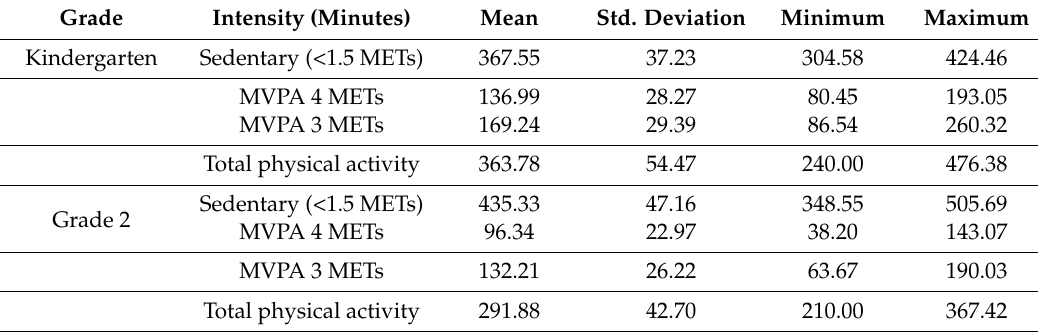
Table 3. Longitudinal sample ( n = 21) physical activity and sedentary behaviour per